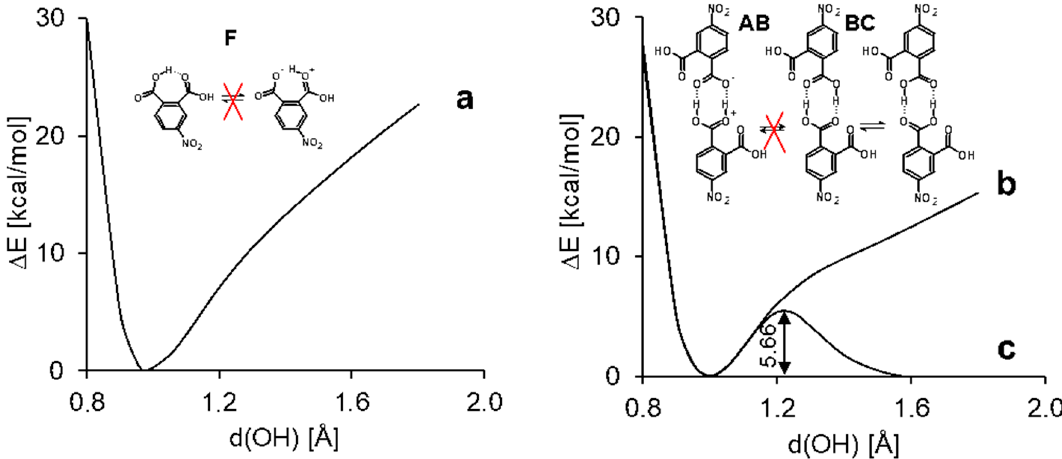
Figure 4. The potential energy profile for a gradual displacement of one proton within the H-bond in the 4(II) monomer ( a ) and the D4(I) dimer ( b and c ) calculated in the PCM approximation in acetonitrile. The curves a and c represent a case when all other structural parameters are optimized. The curve b represents a case when the position of the adjacent bridged proton is fixed.